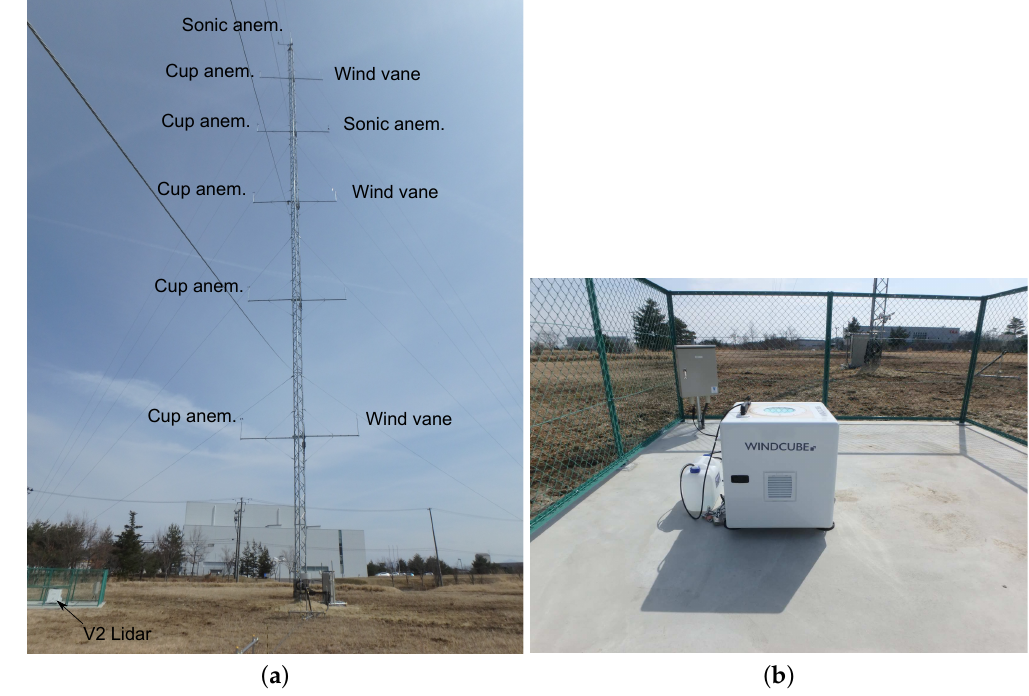
Figure 3. Picture of ( a ) the meteorological mast; ( b ) the V2 profiling